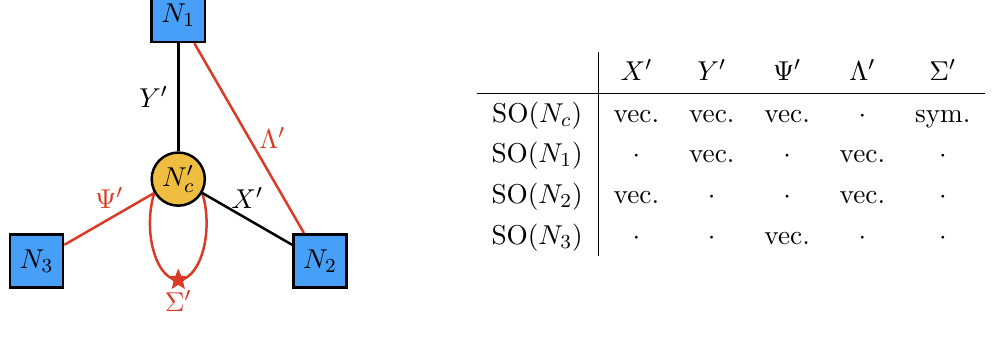
Figure 4 . 2d N = (0 , 1) triality dual of the theory in figure 3. N 0